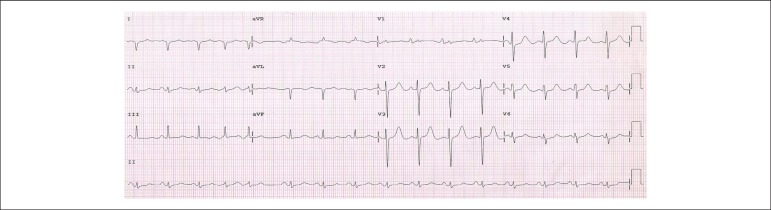
ECG. Sinus rhythm; Both atria overloaded with giant P wave positive at
V1 and overloaded right ventricle.